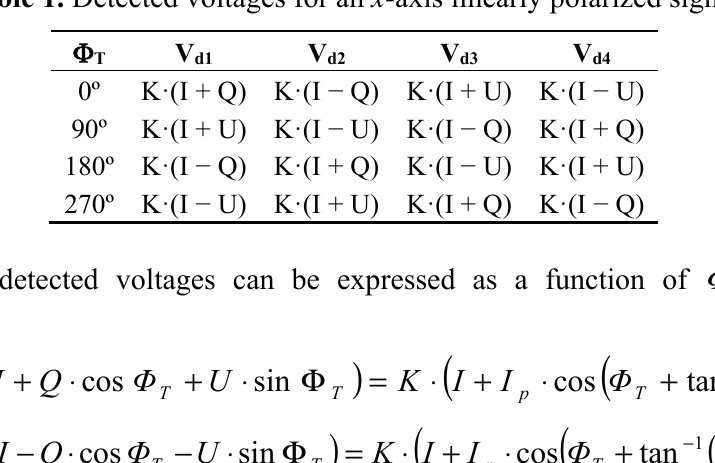
Table 1. Detected voltages for an x -axis linearly polarized